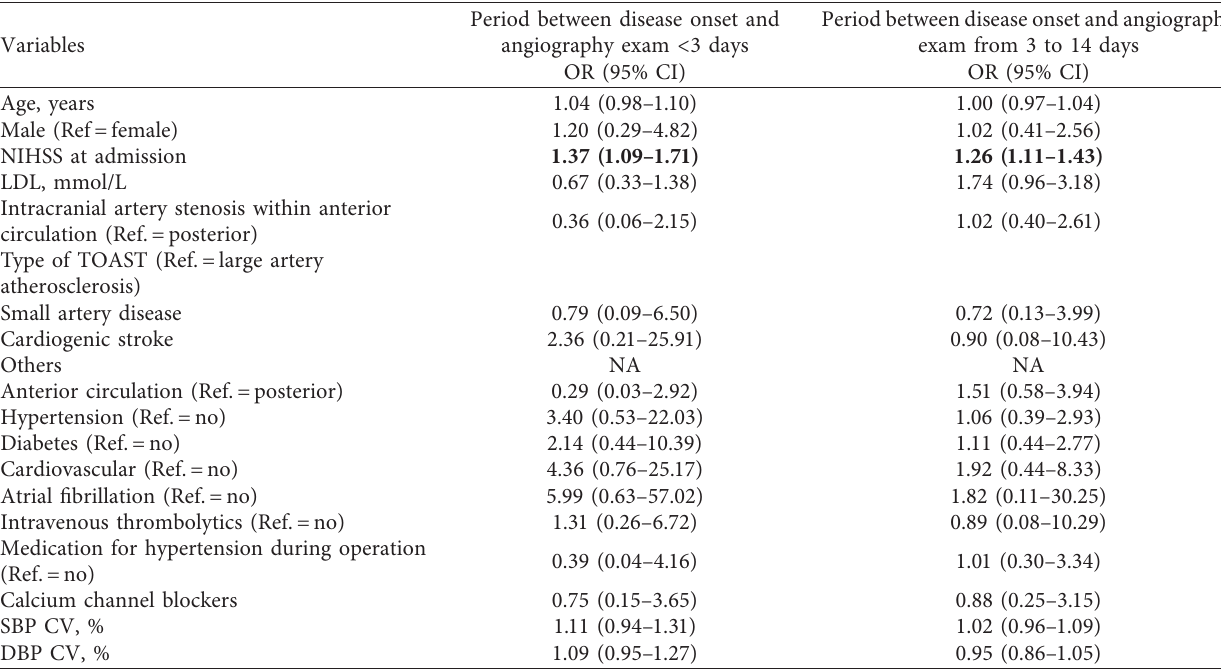
Table 4: Effectors 1 of poor clinical outcomes (mRS > 2 at discharge) in stroke patients undergoing cerebral angiography.